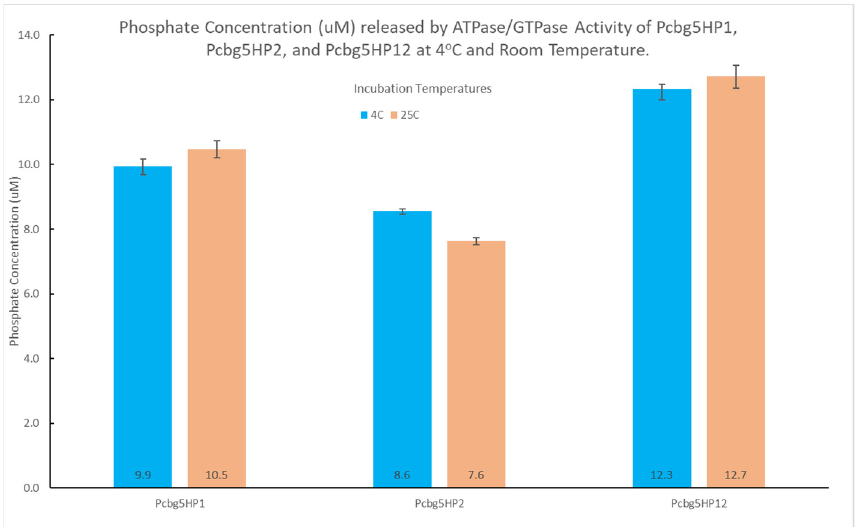
Figure 6. ATPase hydrolysis activity of PCBG5HP1, PCBG5HP2, and PCBG5HP12 recombinant pro- teins at 4 °C and 25 °C. Data were representative of three biological replicates and were expressed as the mean ± SD.